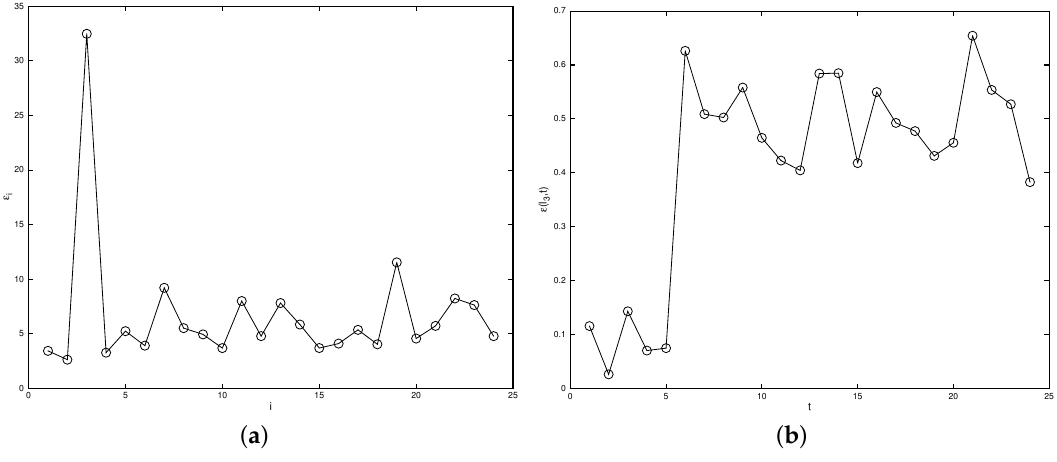
Figure 9. Detecting the malfunctioning sensor by examining ε ( l i , t ) when the error of the sensor is 50%. ( a ) ε i for all i ; ( b ) ε ( l 3 , t ) for all t